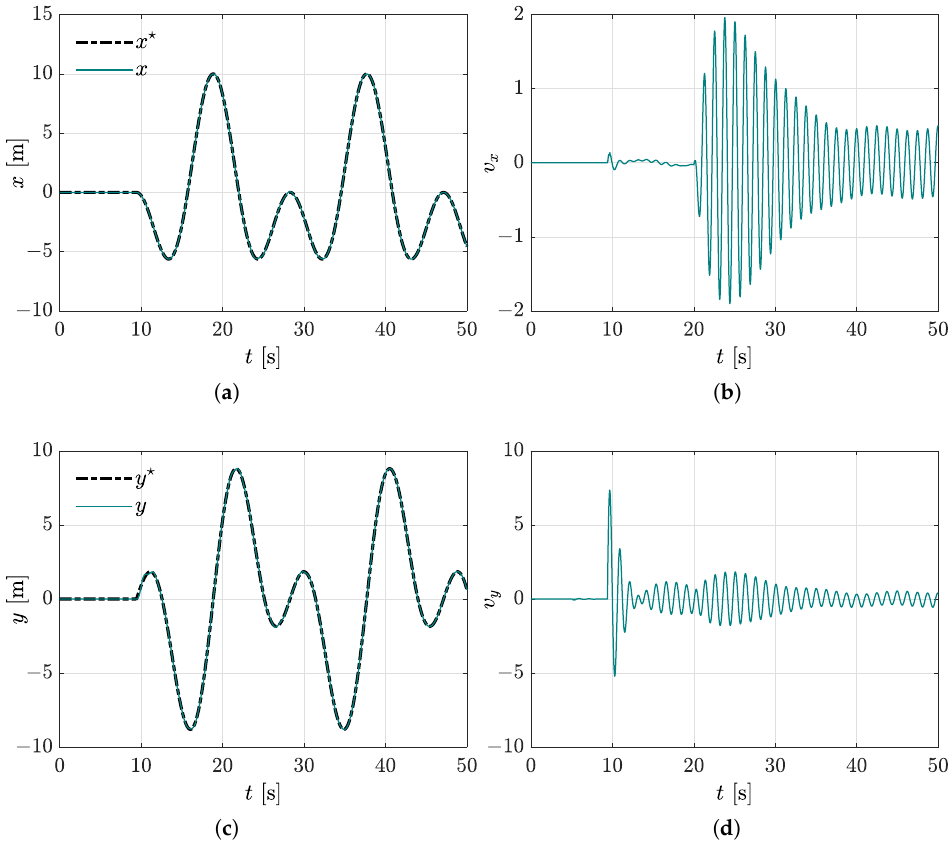
Figure 16. Controlled vertical dynamics, case 2.3. ( a ) Desired x (cid:63) position tracking. ( b ) Virtual controller v x . ( c ) Desired y (cid:63) position tracking. ( d ) Virtual controller v y